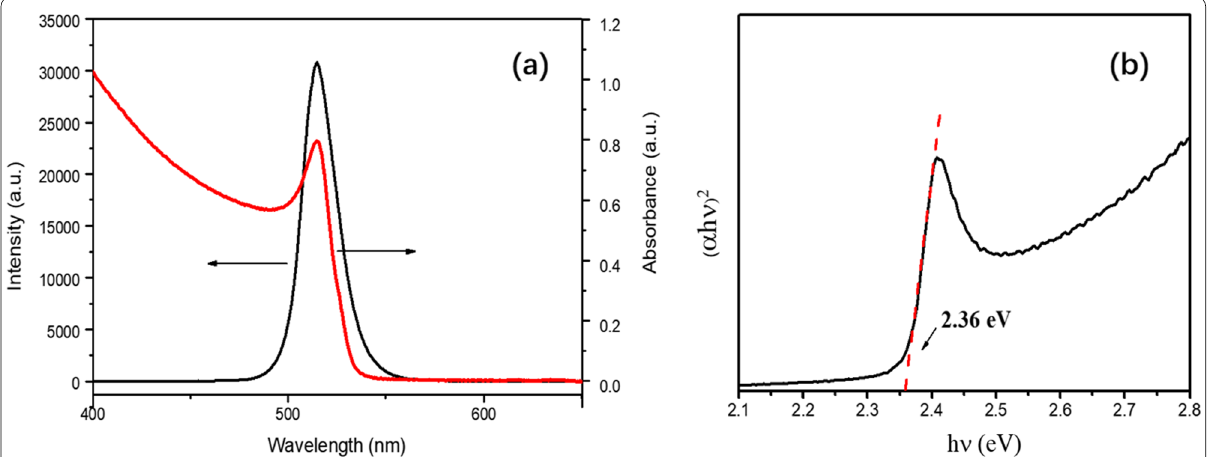
Fig. 2 a The PL and absorption spectra of CsPbBr 3 thin films b Plot of (αhν) 2 versus hν of CsPbBr 3 thin